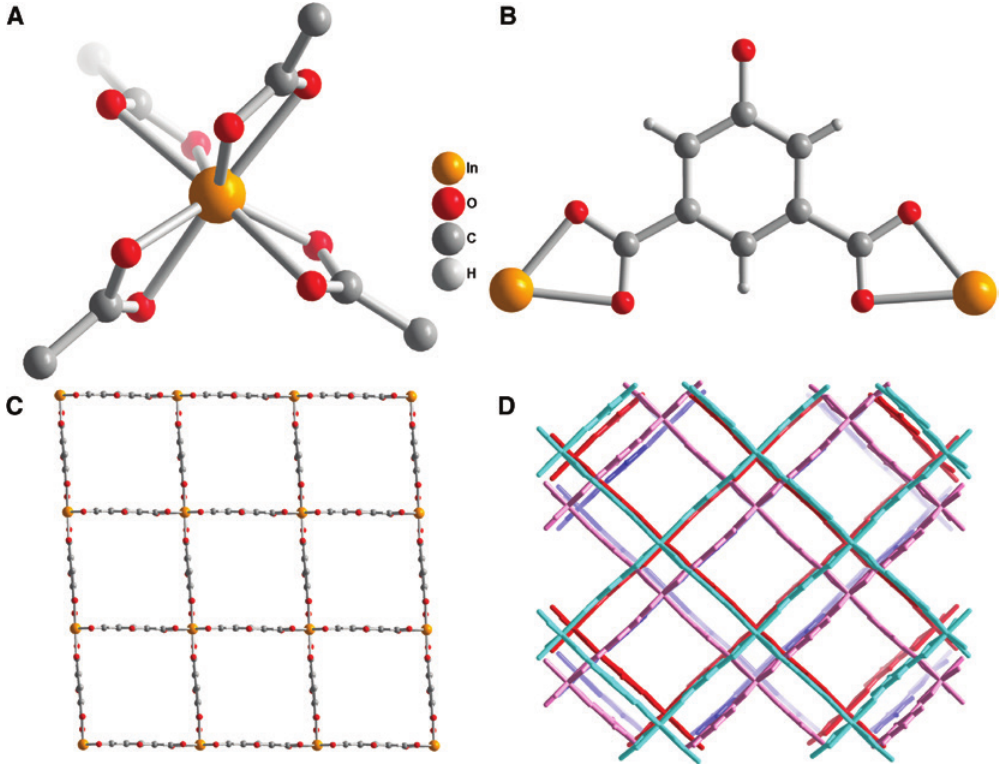
Figure 2: The structural characters for 1 . (A) View for the atoms that shape the coordination surrounding of In(III) ion, (B) view of connecting model of bip ligand in 1 , (C) the single 2D grid network of 1 (the H atoms are omitted for clarity), and (D) the AB packing 2D layered network of 1 .